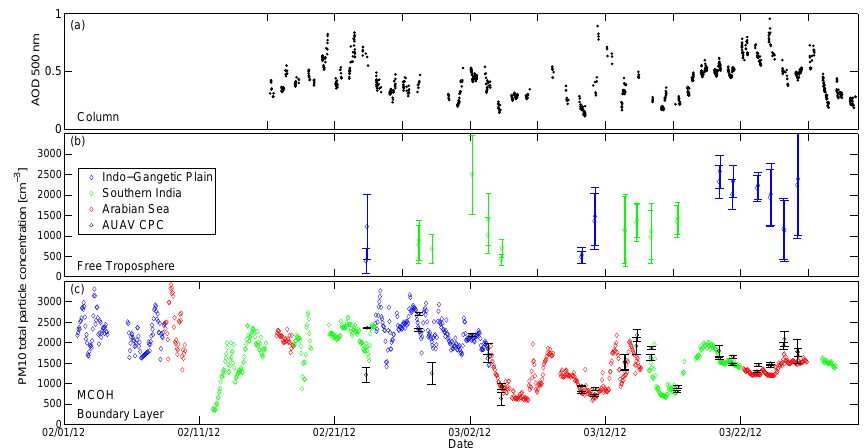
Figure 3. (a) Time series of AOD at 500nm measured by AERONET sun photometer. (b) Time series of the mean total particle concentration with SD in the FT (1000–3000m) measured by CPC onboard AUAV. (c) Time series of PM 10 total particle concentration measured by CPC at MCOH (colored diamonds) and mean total particle concentration with SD in the MBL (0–500m) (black circles) measured by the onboard AUAV CPC. The color coding corresponds to the trajectory cluster analysis shown in Fig. 2 (3 clusters in MBL and 2 clusters in